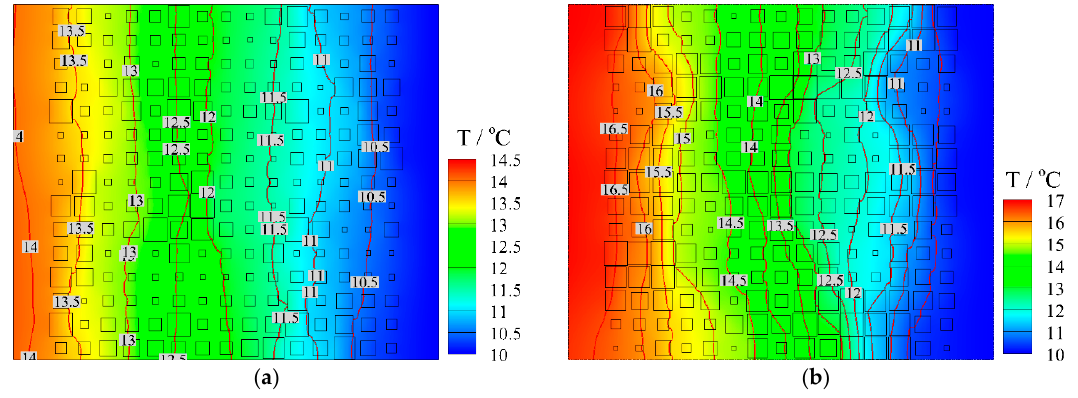
Figure 6. Temperature distributions of fractal porous material ( D = 1.3): ( a ) ε = 0.3; ( b ) ε = 0.5.